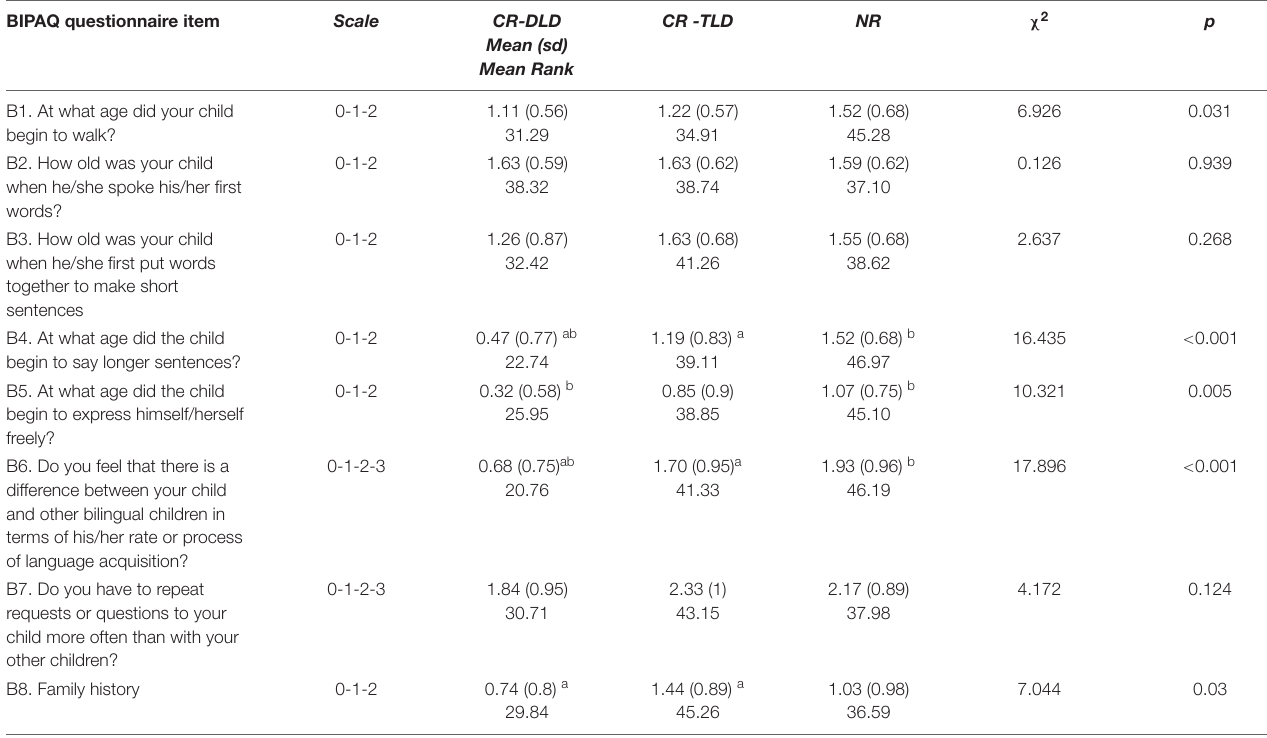
TABLE 3 | Questions Section B: developmental background and family history. BIPAQ questionnaire